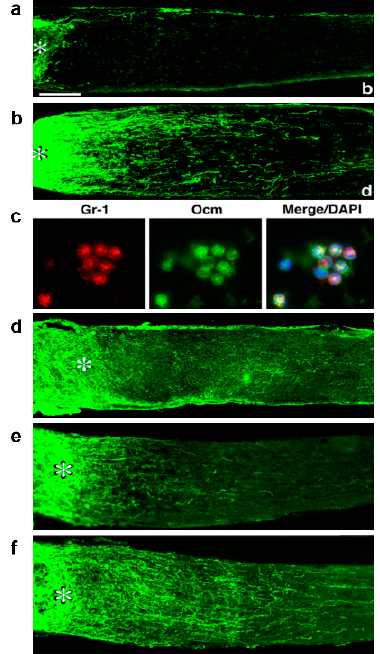
Figure 1. Inflammation-induced optic nerve regeneration and the role of Oncomodulin (Ocm). ( a ) Negative control: Absence of axon regeneration following optic nerve injury (asterisk: site of optic nerve crush injury). ( b ) Intraocular inflammation induced by injury to the lens (shown here) or by other means cited in the text enables retinal ganglion cells (RGCs) to regenerate axons past the injury site. ( c ) Intraocular inflammation is associated with a rapid infiltration of Gr-1-positive neutrophils (red) that express high levels of Ocm (green). ( d ) P1, a peptide antagonist of Ocm based on the N-terminus of the protein, suppresses Zymosan-induced regeneration. ( e ) Slow-release polymer beads containing the cAMP analog CPT-cAMP induce minimal regeneration after optic nerve injury. ( f ) Extensive regeneration with slow-release beads containing Ocm + CPT-cAMP